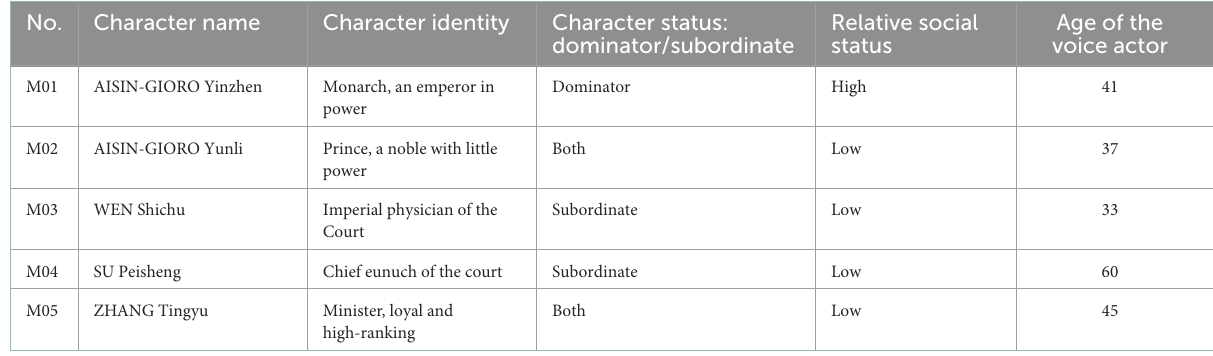
TABLE 1 Information of the selected characters.